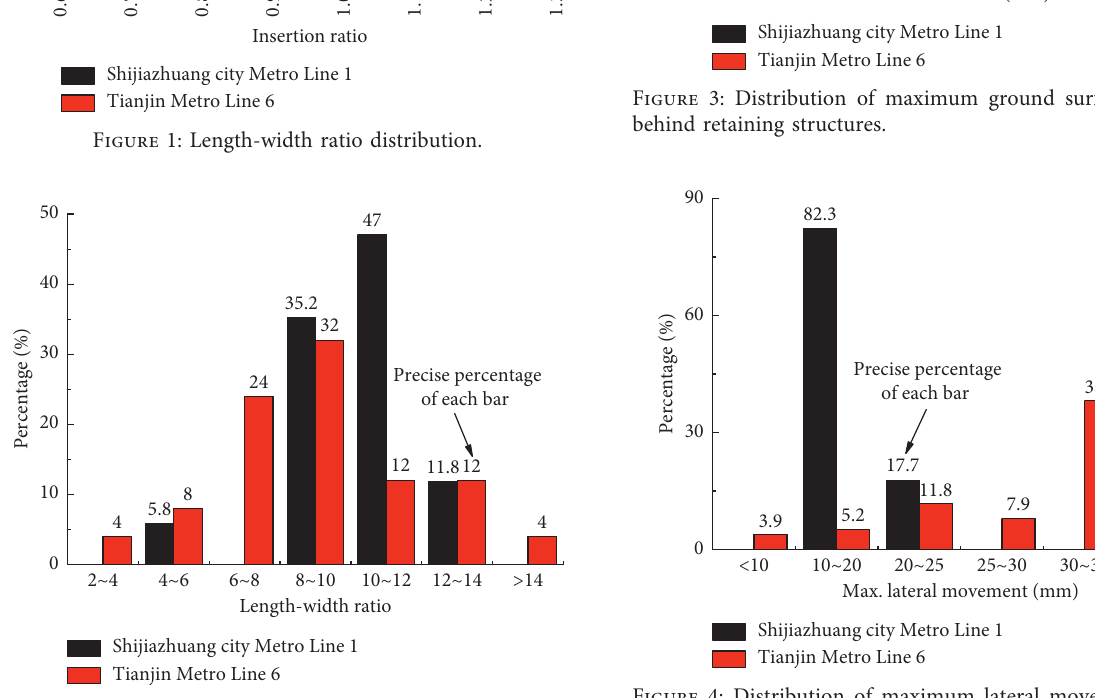
Figure 2: Insertion ratio